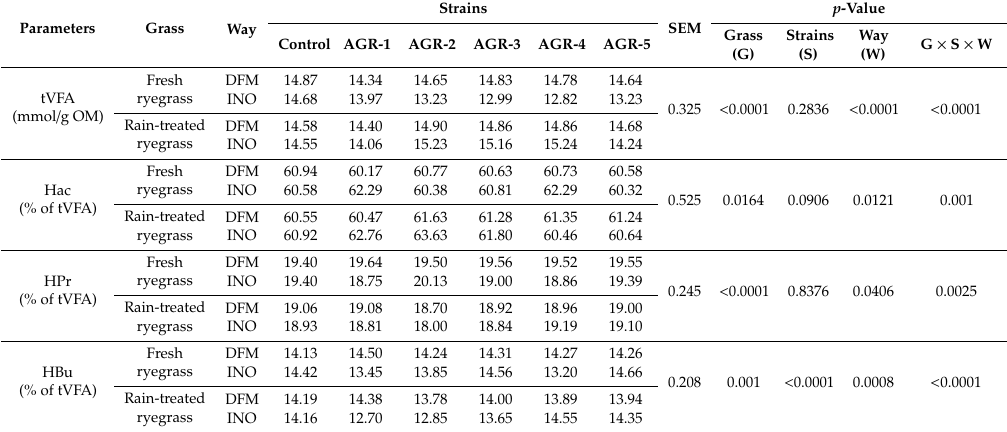
Table 5. E ff ect of LAB strains on fermentation